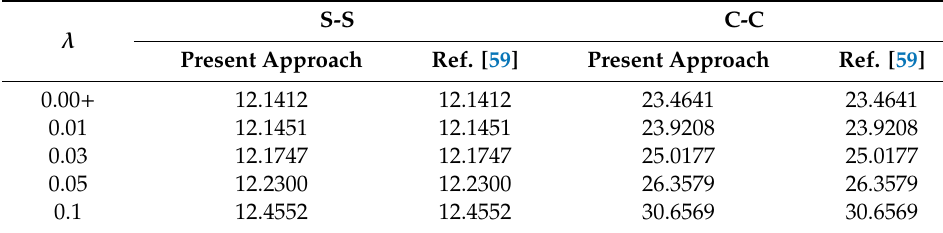
Table 3. Linear dimensionless natural frequencies of homogeneous simply-supported (S-S) and